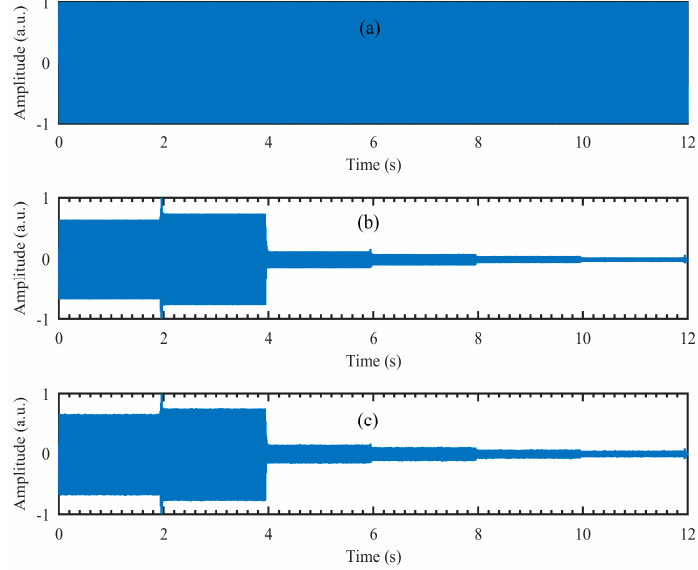
Figure 5. ( a ) The original audio waveform; ( b ) the audio waveform recovered directly from the high-speed video captured by the high-speed camera; ( c ) the audio waveform recovered from the reconstructed high-speed video using the compressive camera with 8 × compression.